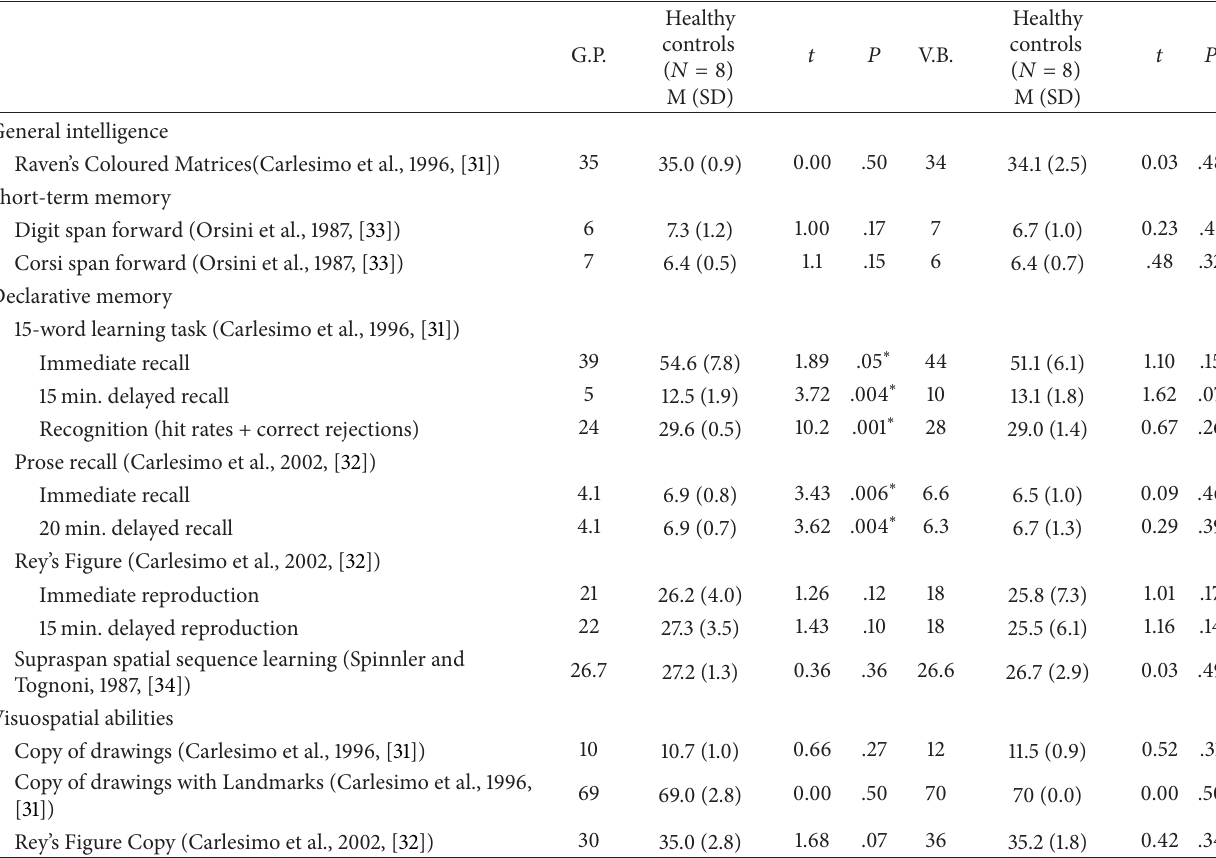
Table 1: Performance scores of G.P. and V.B. on the tests of neuropsychological battery. 𝑡 -tests for significant differences of individual scores from average scores of groups of normal controls are also